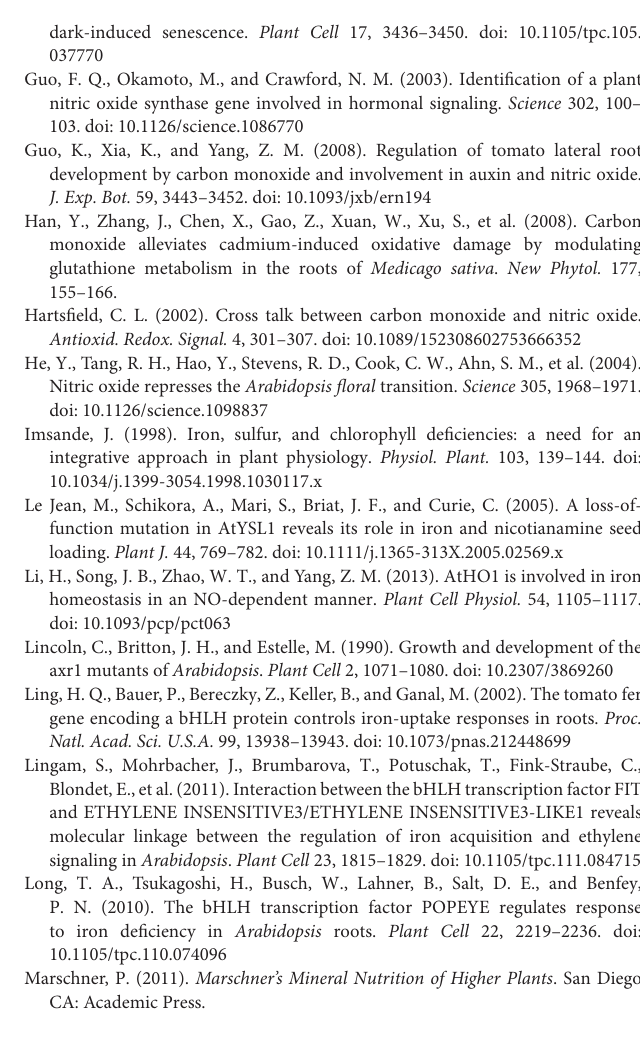
FIGURE S8 | The effects of different inhibitors on Fe content in roots of wild-type Col-0 lines with or without –Fe treatment. Two-week-old wild-type Col-0 lines were treated with 100 nM NAA, 10 µ M NPA, 200 µ M ZnPPIX, 300 µ M cPTIO, 1 mM L-NAME, 10 mM tungstate, 100 nM CORM2, 100 nM CORM2 + 10 µ M NPA, 30 µ M SNAP, 30 µ M GSNO, and 30 µ M SNAP + 10 µ M NPA, respectively, for 1 week, and the Fe content was measured. Data are the means ± SD ( n = 9), and bars with different letters are significantly different at p < 0.05 (Tukey’s test). FIGURE S9 | The effect of various inhibitors on NO generation after –Fe stress. Two-week-old wild-type Col-0 lines were treated with 100 nM NAA, 10 mM NPA, 300 µ M cPTIO, 1 mM L-NAME, 10 mM tungstate, 200 µ M ZnPPIX, 100 nM CORM2, 100 nM CORM2 + 10 µ M NPA, and 30 µ M SNAP, respectively, for 1 day, and the green fluorescence (A) and the corresponding relative fluorescence intensity (B) in the roots were recorded. Data are the means ± SD ( n = 9), and bars with different letters are significantly different at p < 0.05 (Tukey’s test). FIGURE S10 | The effects of various inhibitors on FIT1 and FRO2 expression in the roots of wild-type Col-0 after –Fe stress. Two-week-old Col-0 seedlings were treated with the indicated inhibitors for 1 day, and FIT1 (left) and FRO2 (right) expression in the root were measured by qRT-PCR analysis. Data are the means ± SD ( n = 3), and bars with different letters are significantly different at p < 0.05 (Tukey’s